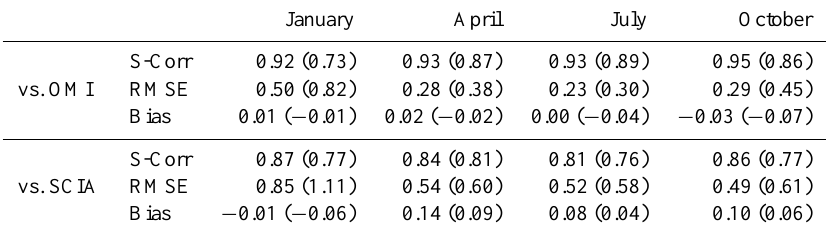
Table 4. Comparisons of tropospheric NO 2 columns between the data assimilation run and the satellite retrievals DOMINO v2 (OMI) and SCIAMACHY (SCIA). The results are obtained from 15-day averages (from the 16th to the 30th of each month) provided for four months in 2005. Shown are the global spatial correlation (Corr), the root-mean-square error (RMSE), and the mean bias in 10 15 molec . cm − 2 . The model simulation results (without data assimilation) are also shown in brackets.